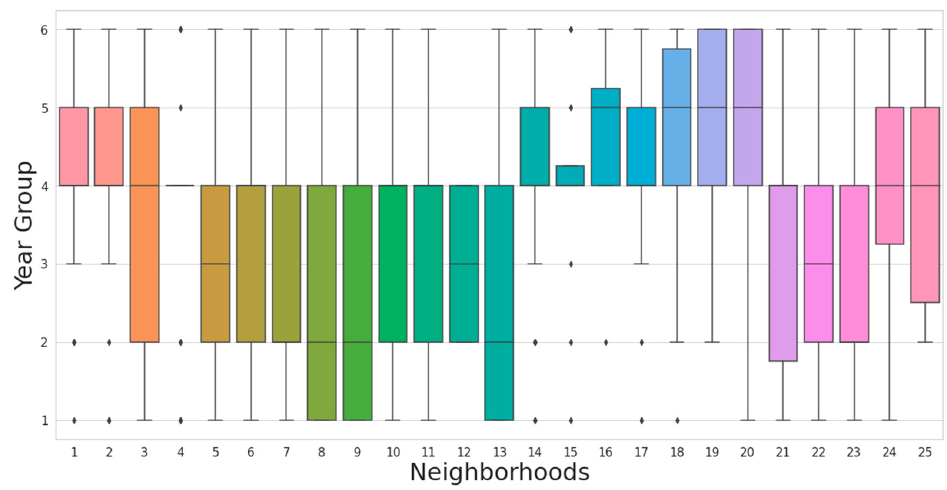
Figure 9. Boxplot of maintenance intervention in the neighbourhood with respect to time.